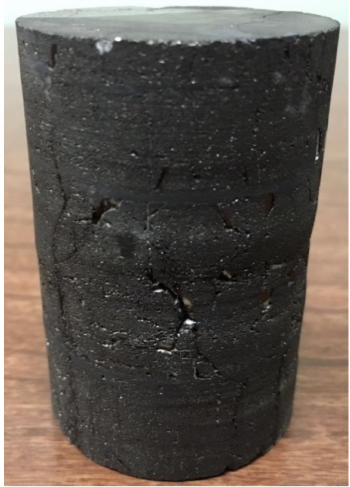
Figure 11. Photograph of a coal sample showing numerous voids and